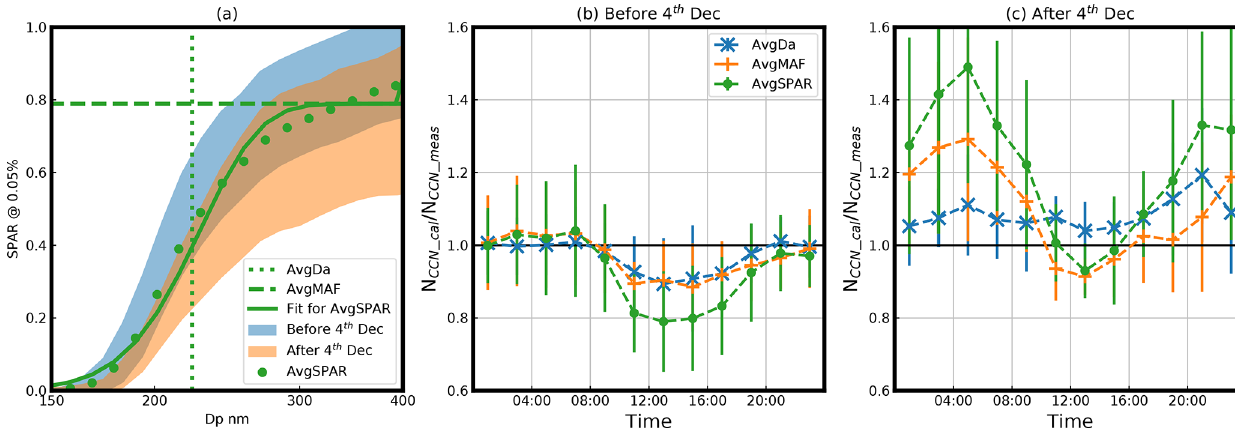
Figure 5. (a) The averaged SPAR at SS of 0.05% during the campaign (green scatters), the corresponding fitting curve (green line) and the averaged fitting parameters (dotted line for D a and dashed line for MAF). The blue and yellow shaded areas represent the variations of SPAR before 4 December and after 4 December, respectively. The ratio between calculated N CCN and measured N CCN (b) before and (c) after 4 December. Bars represent 1 standard deviation, and colors represent different calculation of SPAR curves: green represents average SPAR during the campaign (AvgSPAR), yellow represents SPAR calculated with average D a and real-time MAF (AvgDa) and blue represents SPAR calculated with average MAF and real-time D a